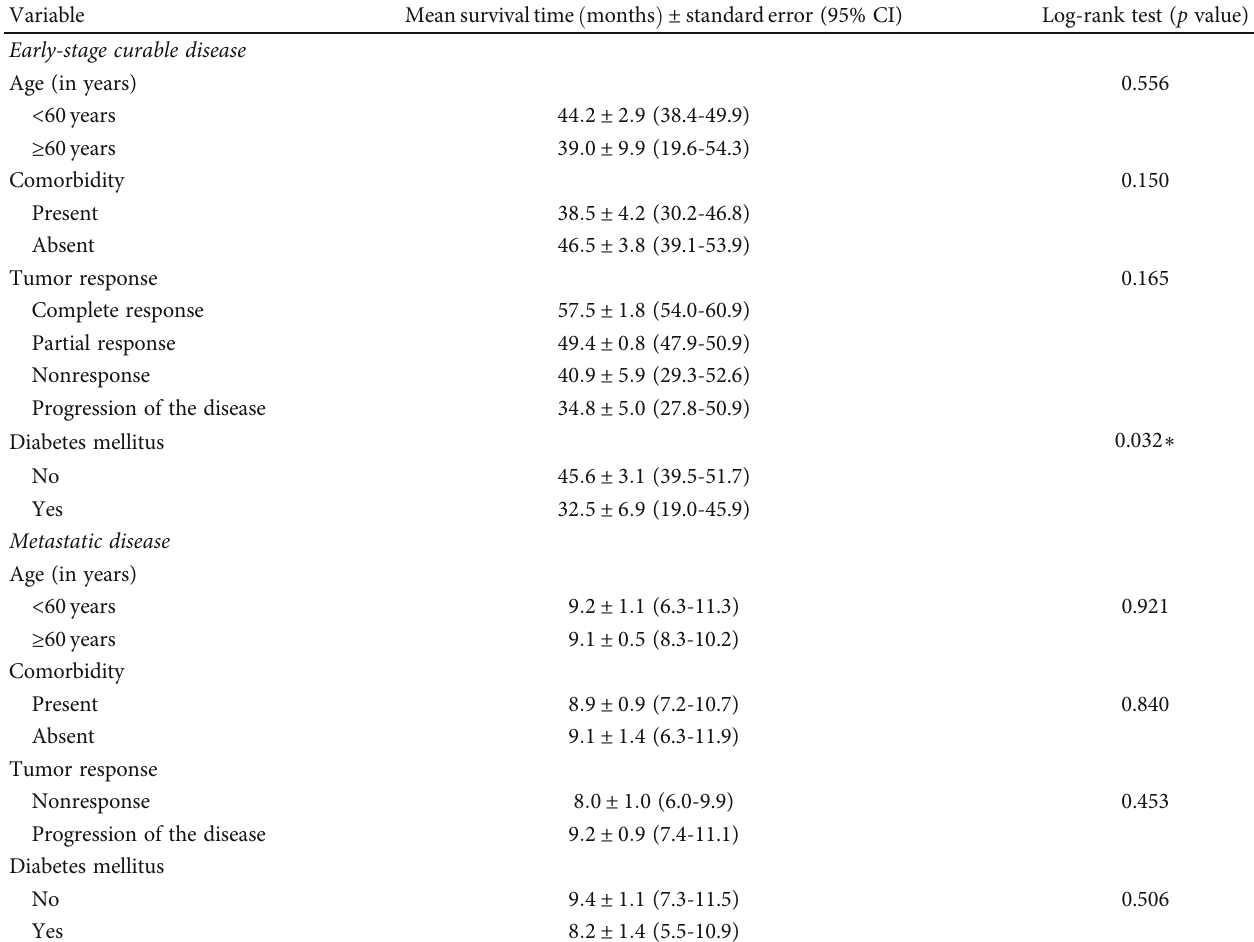
Table 4: Mean survival time estimates among HER2-positive breast cancer